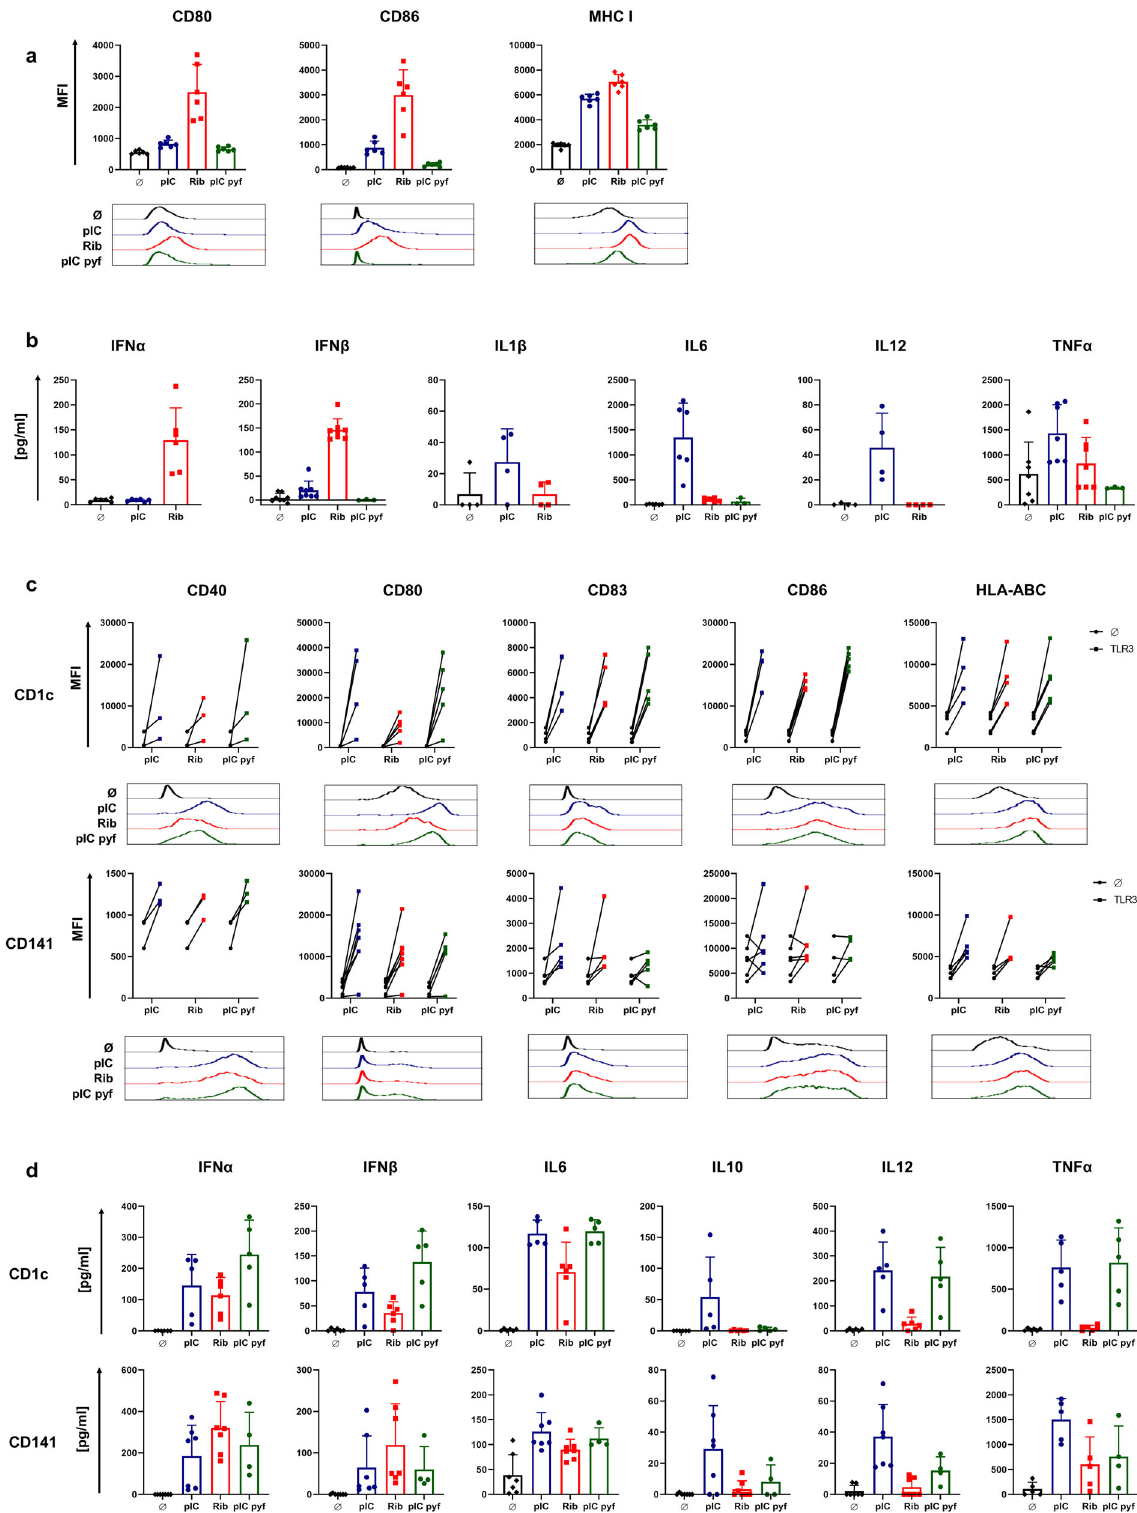
are the most relevant target of cancer vaccines due to their superior capacity to cross-present tumor antigens to CD8 + T cells 21 . The advantage of encapsulating Riboxxim into PLGA relies on its intracellular traf fi cking into the endosome, where TLR3 is located. Consistently, MP-Riboxxim ef fi ciently induced expression of DC activation and maturation marker in